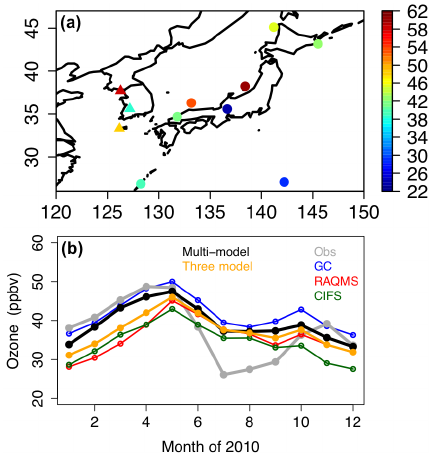
Figure 3. (a) May–June 2010 period-mean surface O 3 observations in ppbv at eight Japanese (filled circles) and three South Korean (filled triangles) EANET sites. (b) Observed and modeled monthly mean surface O 3 in 2010 at all eleven EANET sites. The “Multi- model” and “Three model” in the legend indicate the mean values of all eight global models and only of the three boundary condition models,